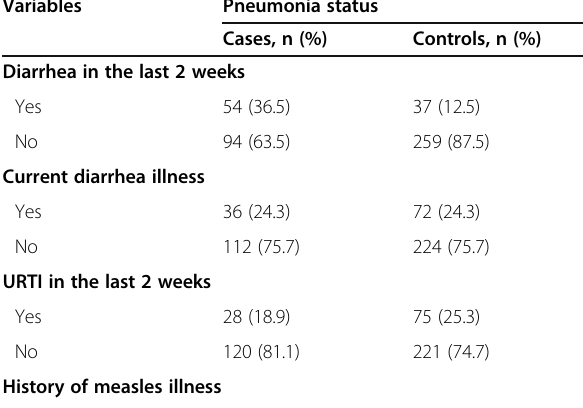
Table 4 Common childhood illnesses and related care practices of children 2 – 59 months of age in Northeast Ethiopia, 2019